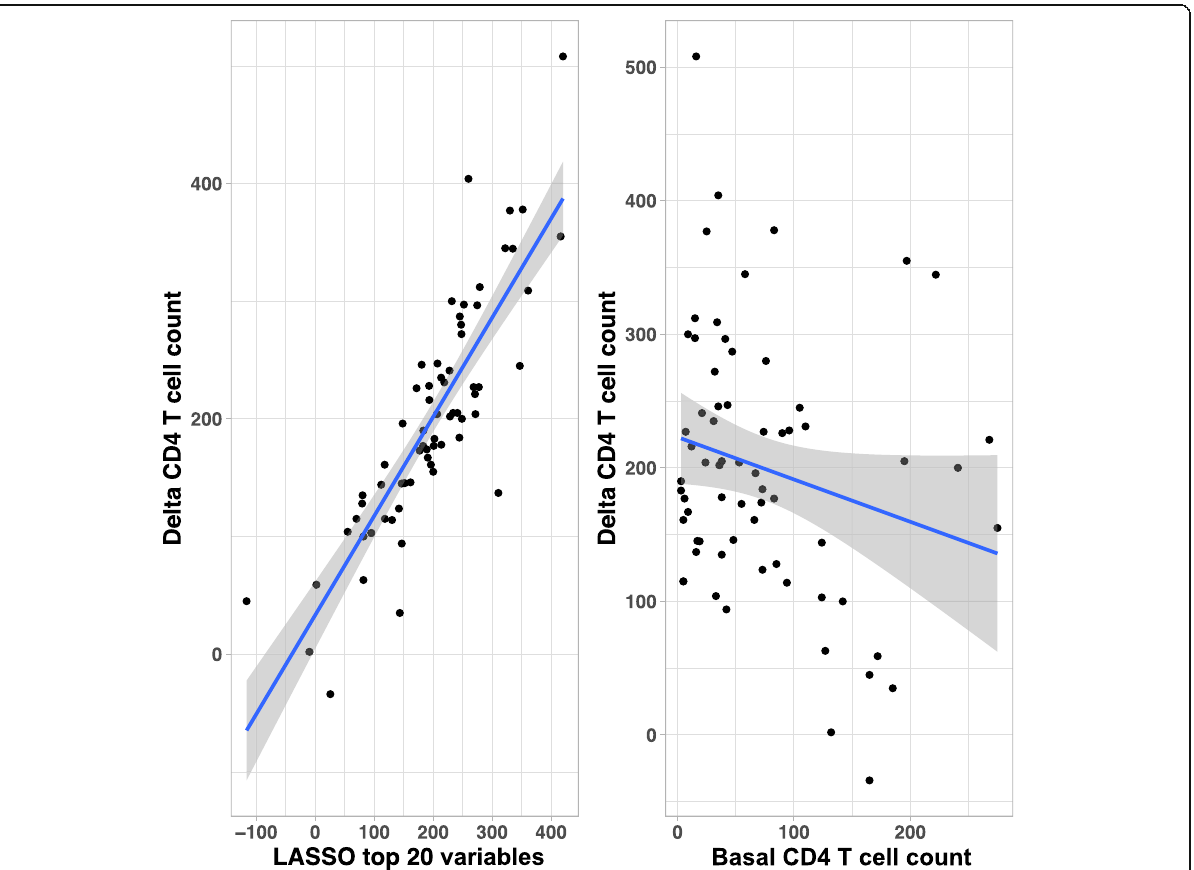
Fig. 3 Comparison of linear models using A, Top 20 LASSO variables, and B, basal CD4 T cell counts, as predictors of net increment in CD4 T cell counts after 52 weeks on ART ( “ delta T CD4 ” ). For A, regression was performed using leave-one-out cross validation, performing N linear regressions, training with N-1 samples, plotting the predictions for the sample that was unknown to the model. Adjusted R 2 = 0.71960667, F